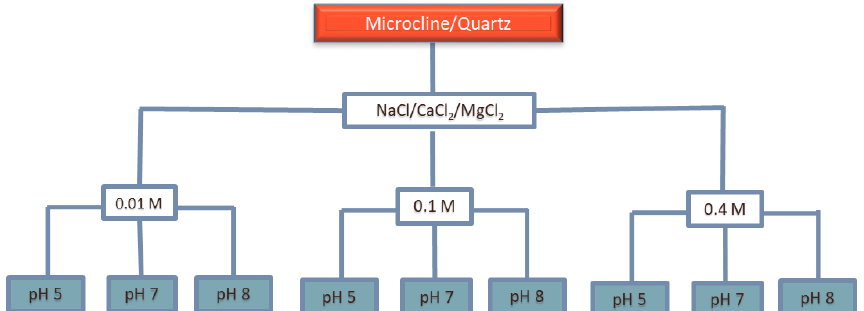
Figure 2. Statistical design of solution composition to investigate the role of salt type, salt concentration, and pH on the IN activity of microcline and quartz samples. The experiments were performed for suspension concentrations of 2wt% for microcline and 1wt% for quartz in solutions of the three salts NaCl, CaCl 2 , and MgCl 2 , with each salt at the three indicated concentrations and with each concentration at three different pH